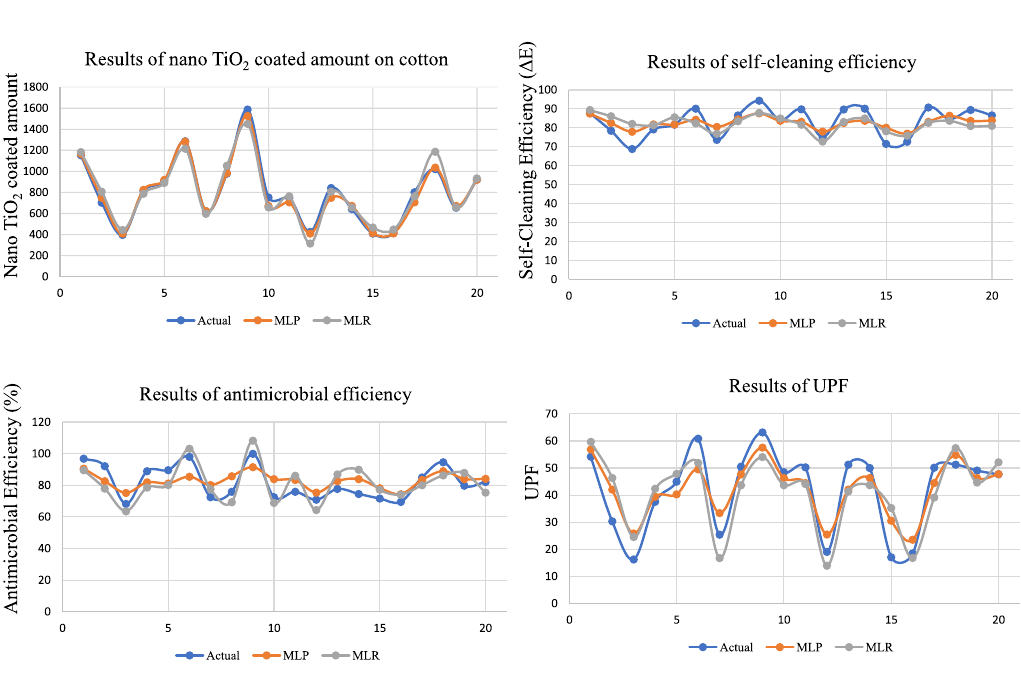
Figure 4. The predicted and actual values using MLP and